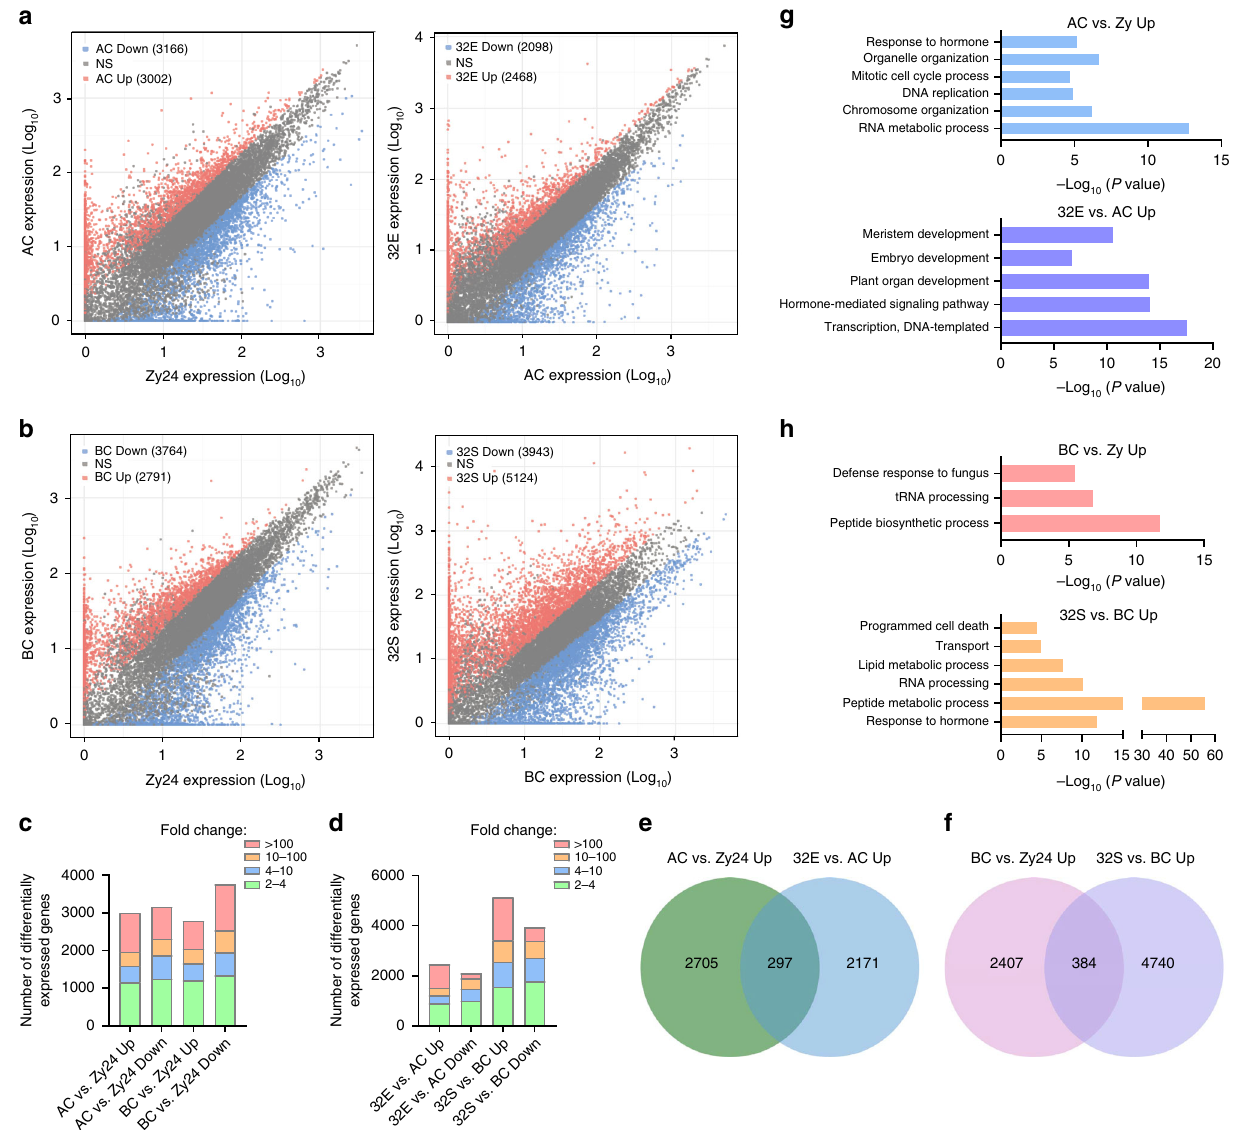
Fig. 2 Global temporal dynamics of gene expression during apical and basal cell lineage development. a , b Scatterplot showing temporal dynamics of gene expression in the process of apical ( a ) and basal ( b ) cell lineage speci fi cation. Pink dots indicate upregulated genes, and blue dots indicate downregulated genes. c Graph showing the number of differentially expressed genes between AC and Zy24 or between BC and Zy24. d Graph showing the number of differentially expressed genes between 32E and AC or between 32S and BC. e , f Comparisons of upregulated genes between AC/Zy24 and 32E/AC ( e ) or between BC/Zy24 and 32S/BC ( f ). g , h GO analysis of upregulated genes in apical ( g ) and basal cell linage ( h ) at 1-cell and 32-cell embryo stages,